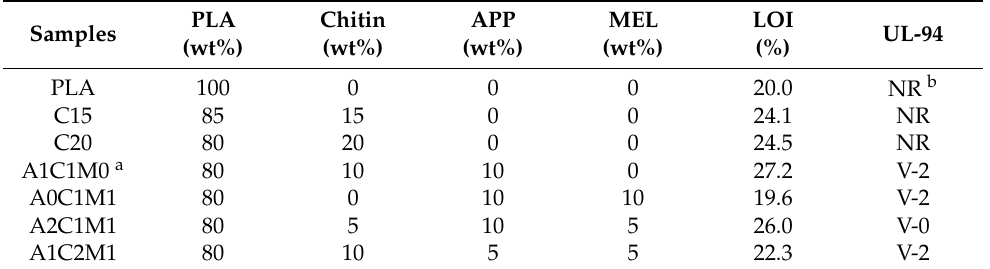
Table 1. Formulations and flammability of PLA and flame-retardant PLA composites.